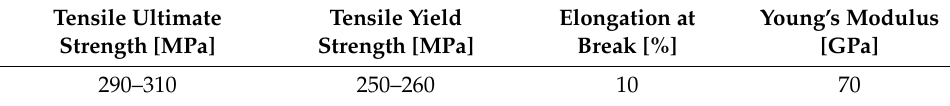
Table 2. Chemical composition and mechanical properties of AA6082T6 sheets.